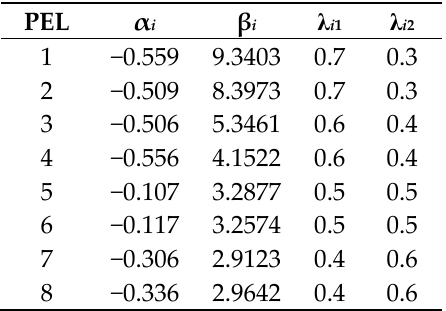
Table 1. Weight Values of PEL Response Satisfaction.